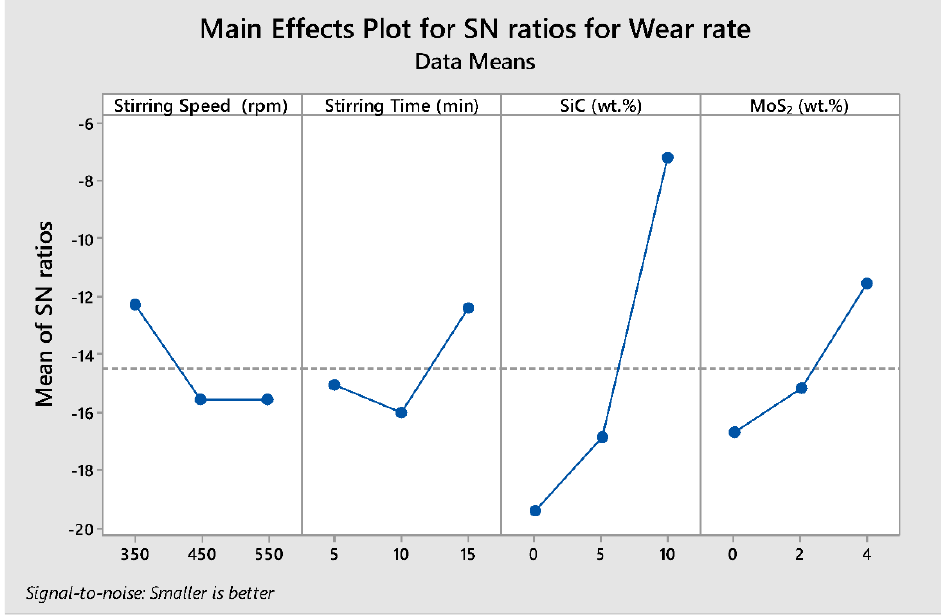
Figure 8. Main effect plots for S/N ratio of wear rate.